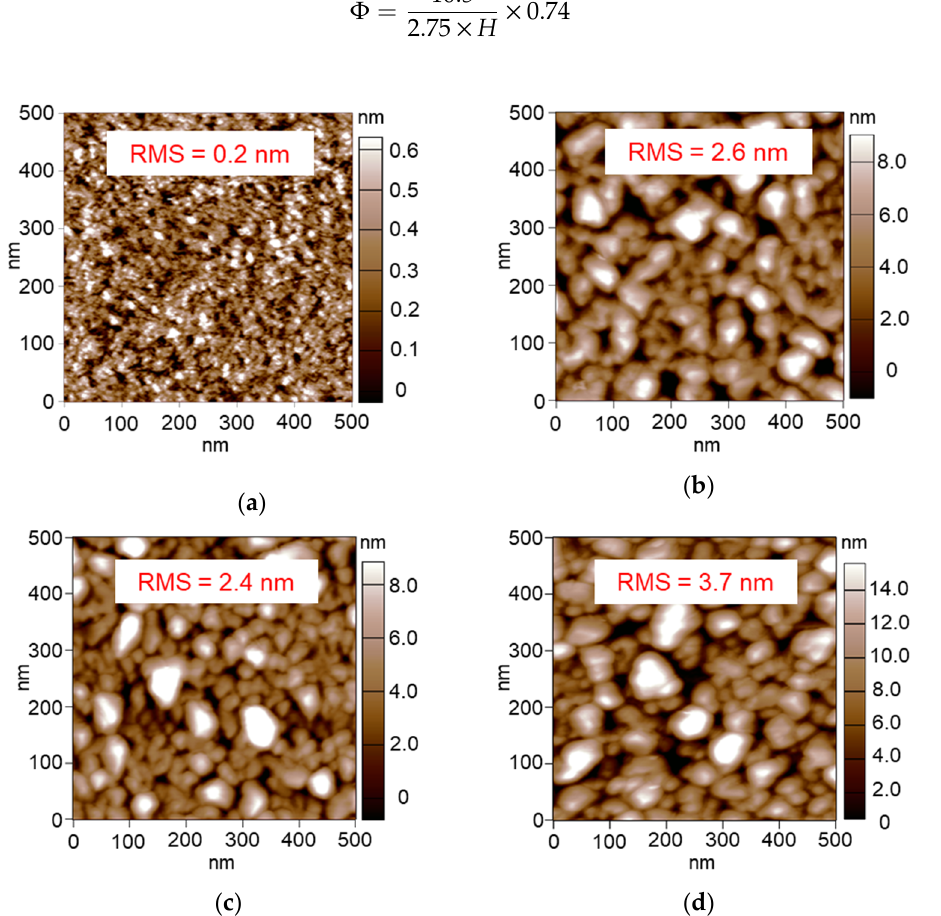
Figure 8. AFM images of 60 s ‐ sputtered Pt/Al 2 O 3 substrates calcined at ( a ) 450 °C, ( b ) 550 °C, ( c ) 570 °C and ( d ) 600 °C.